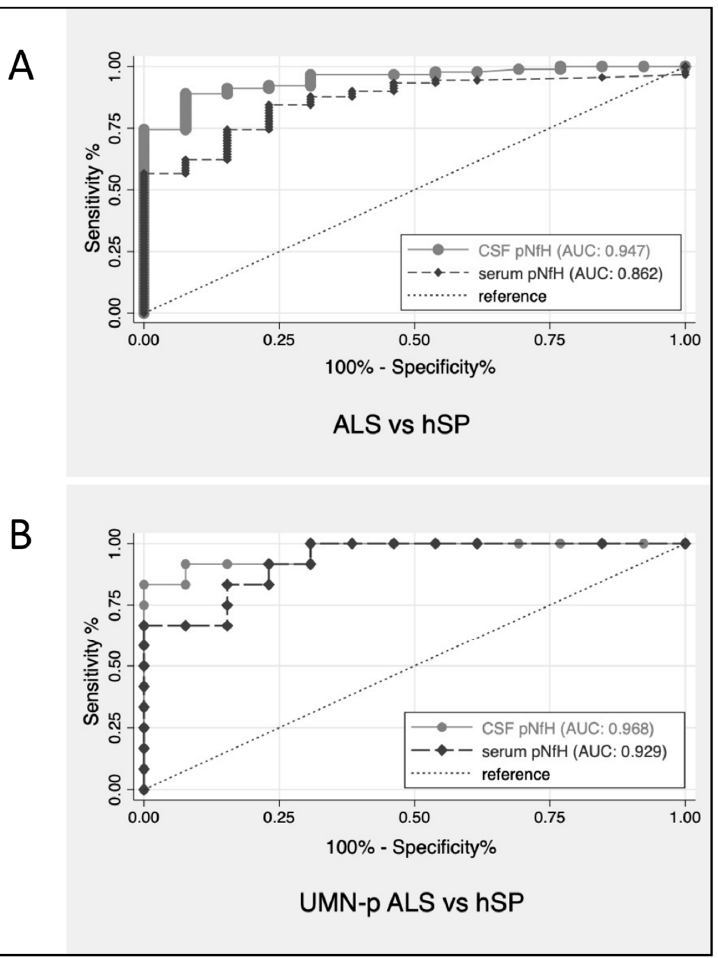
Figure 2. ROC curves for CSF pNfH for discrimination of patients with ALS versus hSP ( A ) and UMNp-ALS versus hSP ( B ). ALS, amyotrophic lateral sclerosis; AUC, area under the ROC curves; CSF, cerebrospinal fluid; hSP, hereditary spastic paraparesis; pNfH, phosphorylated neurofilament heavy chain; ROC, receiver operating characteristic; UMNp-ALS, upper motor neuron